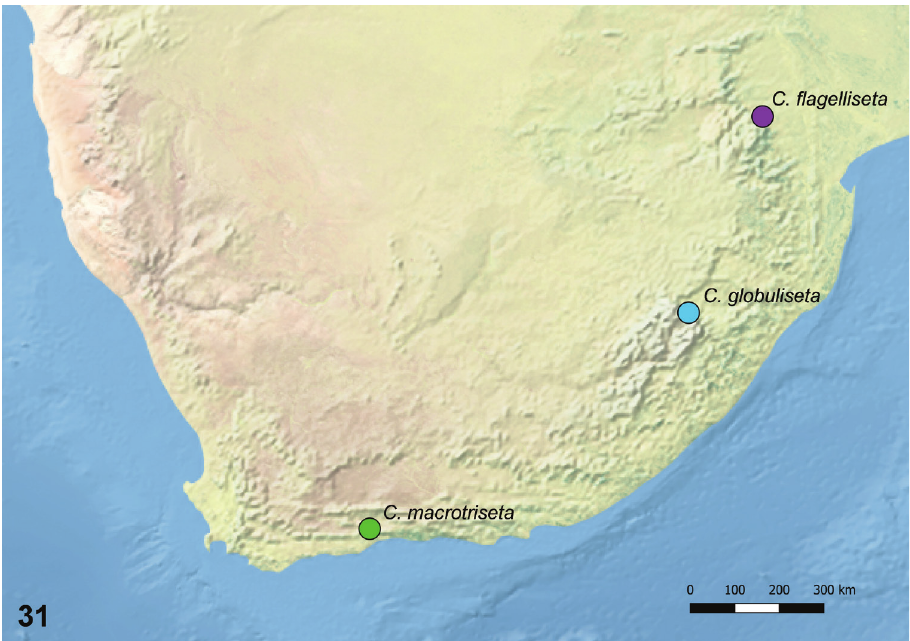
Figure 31. Distribution map of Coenosia flagelliseta sp. nov., C. macrotriseta and C. globuliseta in South